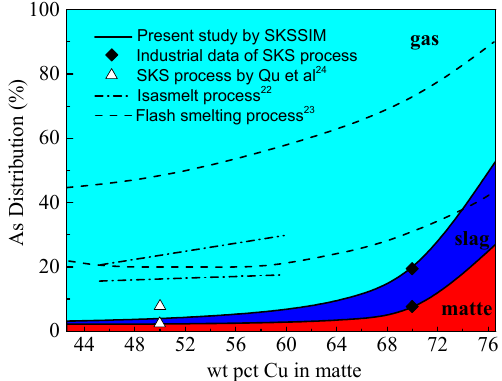
Figure 5. Arsenic (As) distribution in the SKS smelting process.